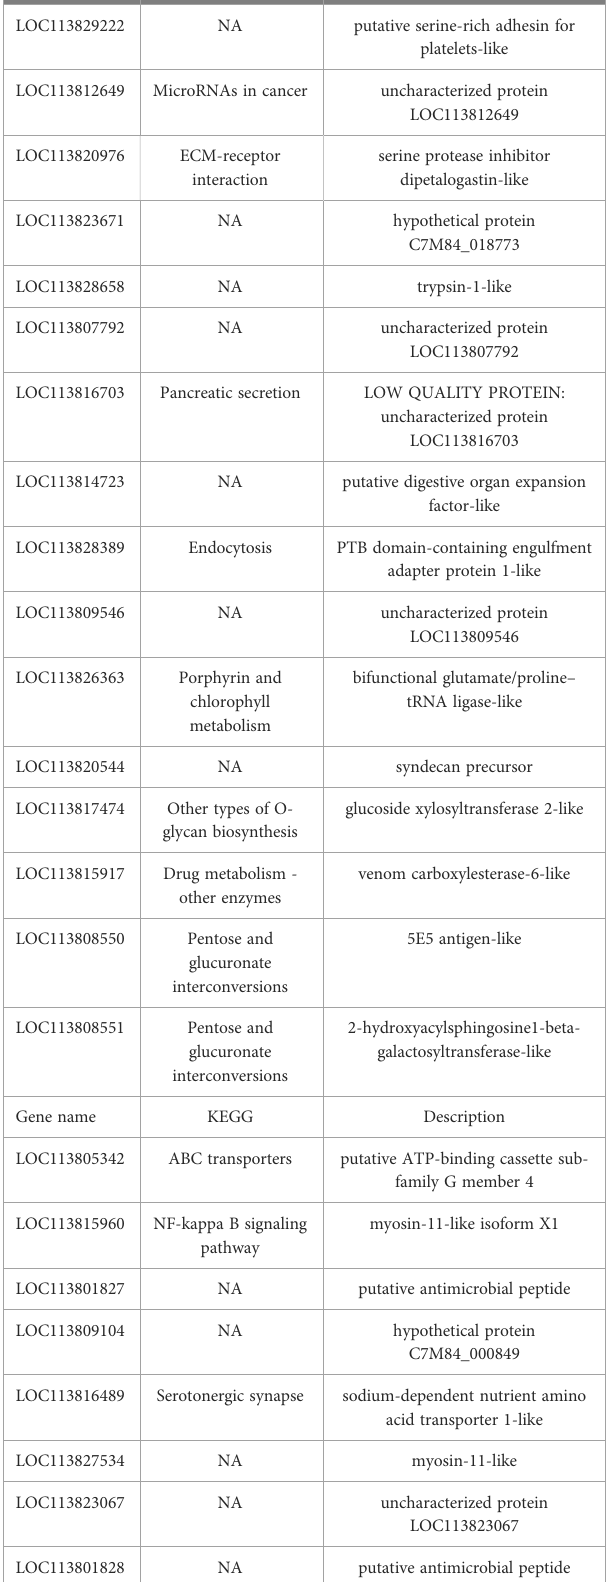
TABLE 2 The infection of Zoea larvae and adults with Vibrio parahaemolyticus co-up-regulates 36 genes. Gene name